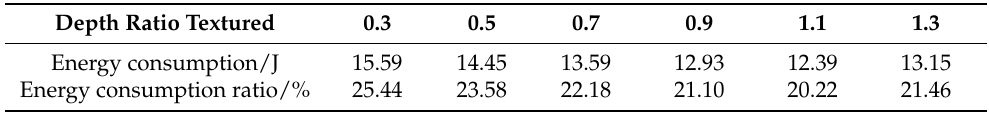
Table 3. Energy consumption and its ratio in one cycle with different depth ratio textured when area ratio textured is